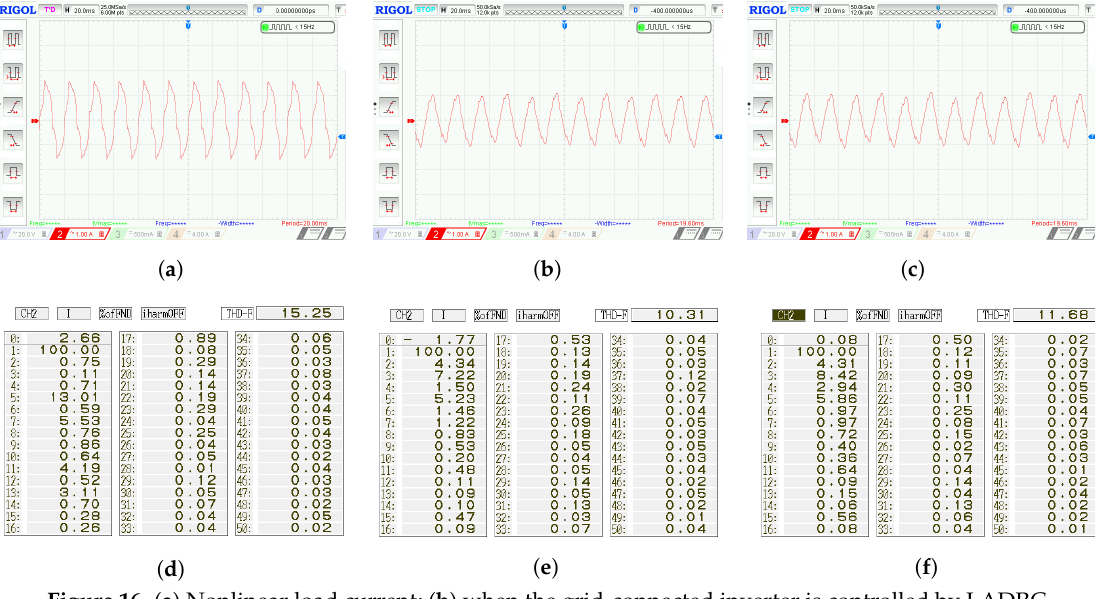
Figure 16. ( a ) Nonlinear load current; ( b ) when the grid-connected inverter is controlled by LADRC the grid current waveform; ( c ) when the grid-connected inverter is controlled by PI, the grid current waveform; ( d ) THD for ( a ); ( e ) THD for ( b ); ( f ) THD for ( c